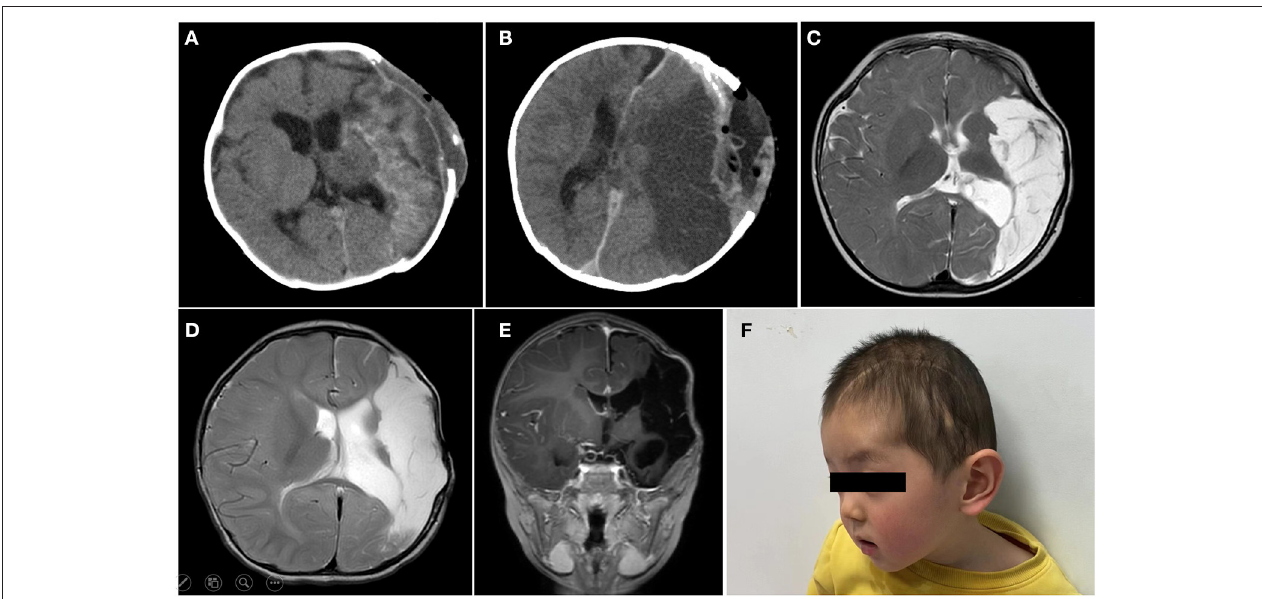
FIGURE 4 | On postoperative-day (POD) 3 (A) and POD 14 (B) , head CT re-examination revealed no tumor residues. The brain MR examination of 6 months (C) , 12 months (D,E) postoperatively, suggested ischemic and liquefaction changes in the part of left frontal and temporal lobes and basal ganglia. No local recurrence or metastasis was observed. (F) Briefly, 12 months postoperatively, a skull defect can be seen in the forehead of the patient, and the spontaneous facial expressions are symmetrical but involuntary salivation was